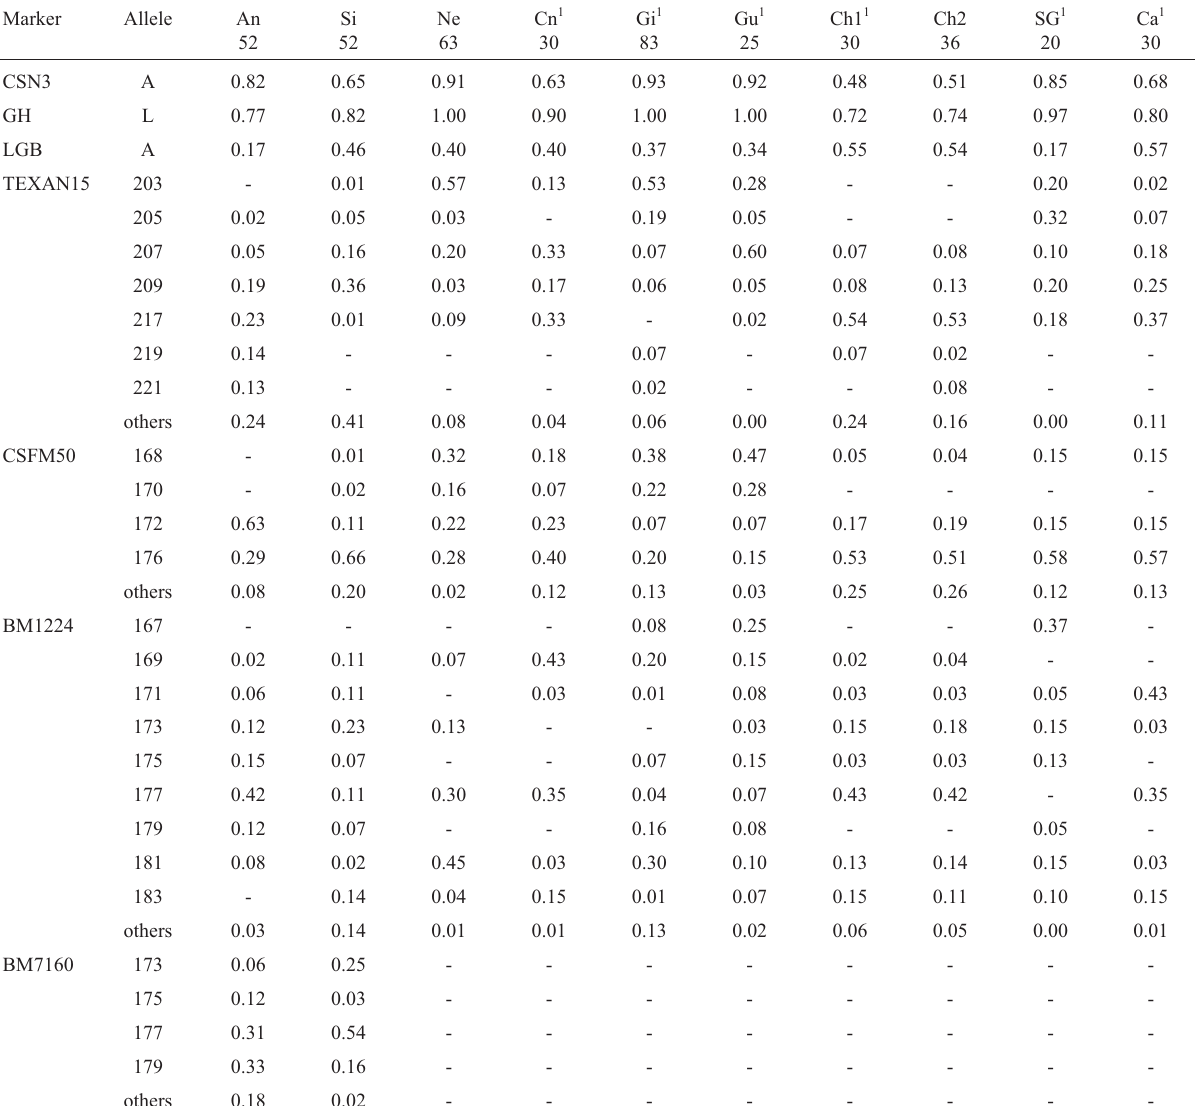
Table 2 - Allele frequencies for the seven markers in ten bovine populations.